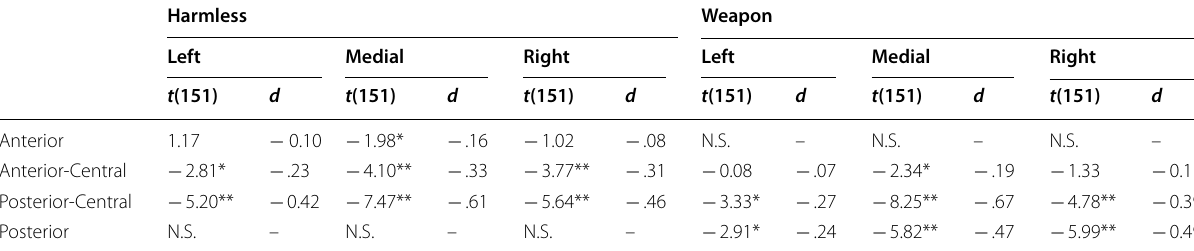
Paired sample t tests reporting significanceand effect size (Cohen’s d) of Correctness effects on PE amplitudes, as a function of object type (harmless vs. weapon) across electrodepositions: left, medial, right (LMR) and anterior‑to‑posterior (ACP). N.S. indicates that the higher order interactions were non‑significant and did not justify t tests at a given scalp location * p < .05; ** p <